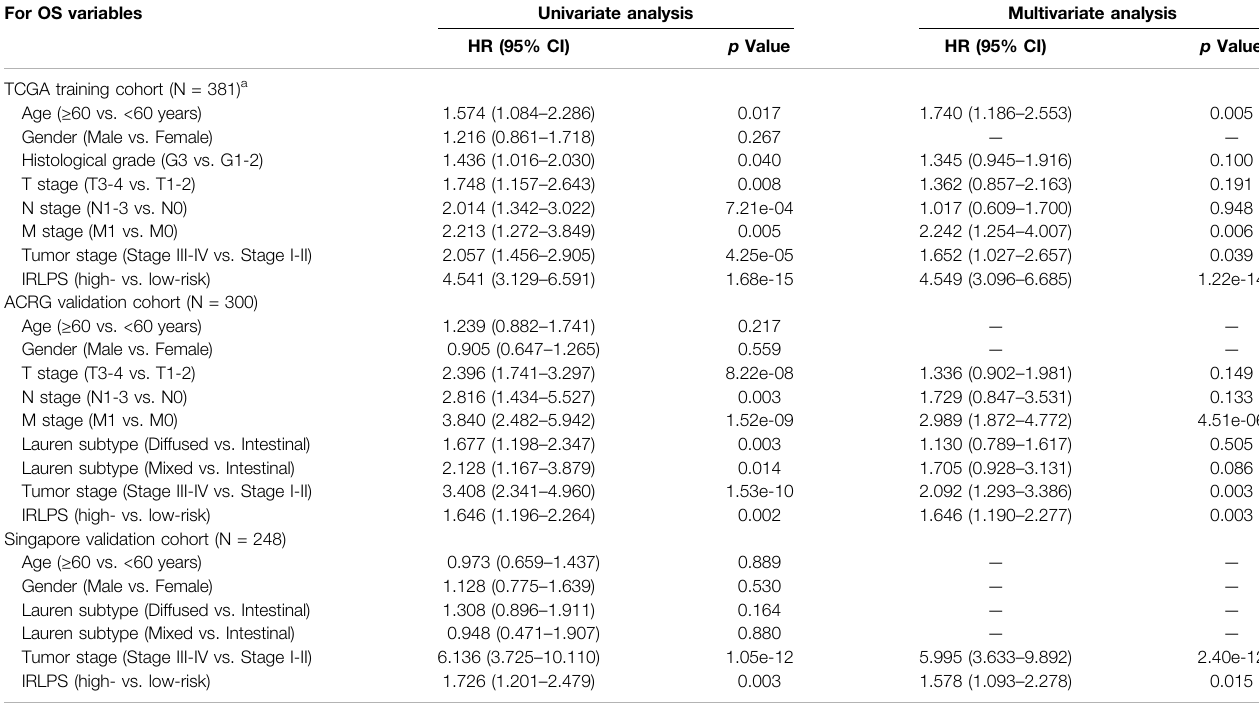
TABLE 1 | Univariate and multivariate Cox regression analysis of clinicopathologic factors and IRLPS for predicting OS in the training and validation cohorts. For OS